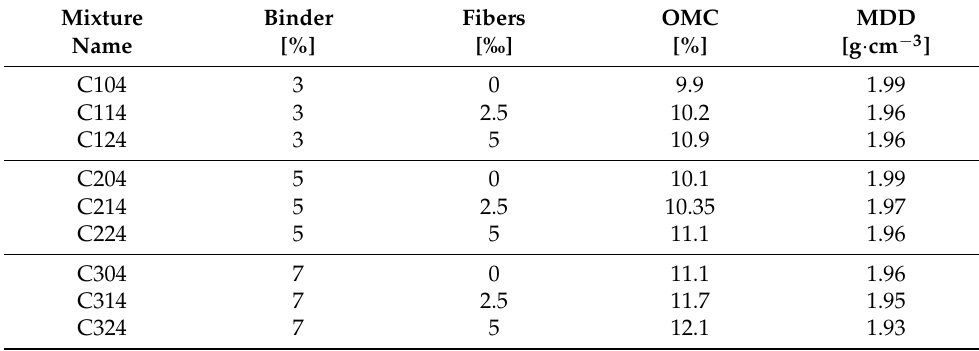
Table 4. Overview of the mixtures.